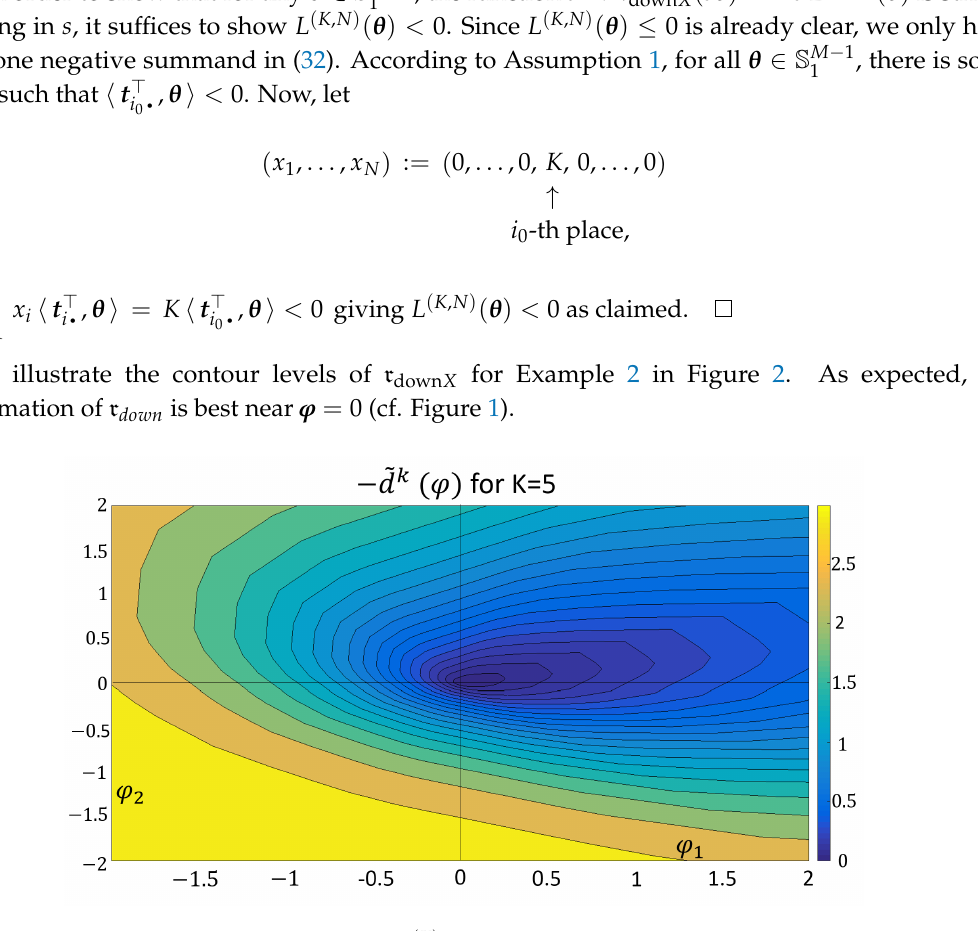
Figure 2. Contour levels for r ( K )